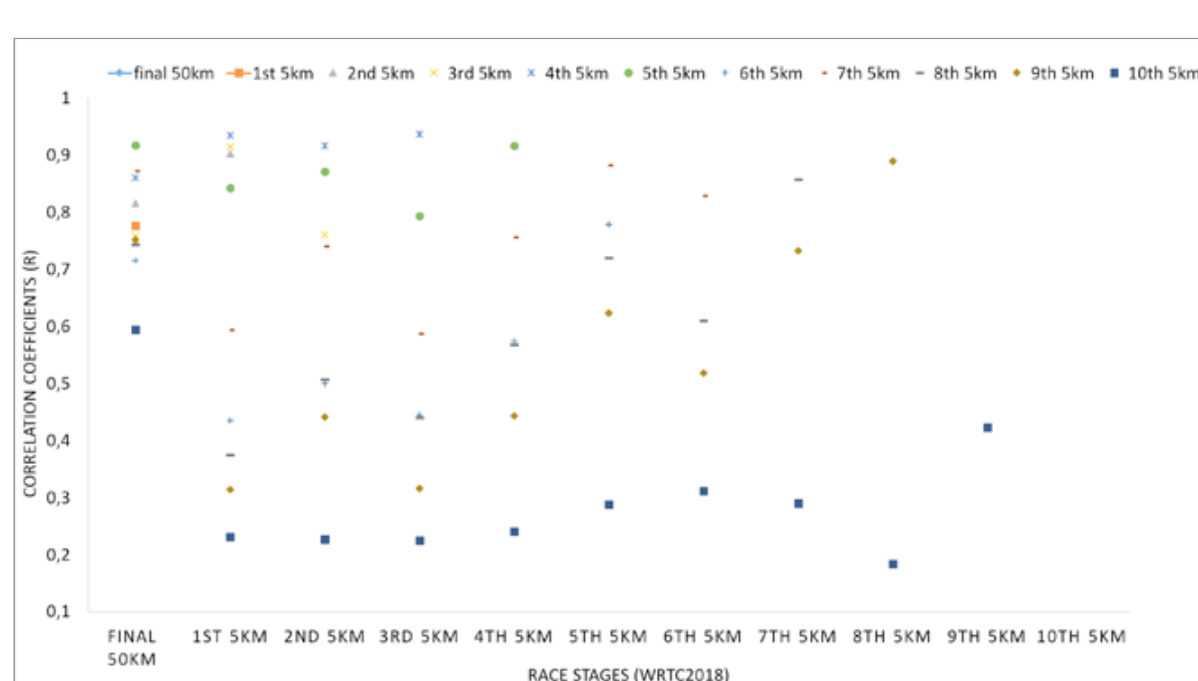
Figure 6 . Correlation coefficients (r) between the performance times averages of the women’s 50km racewalking stages in